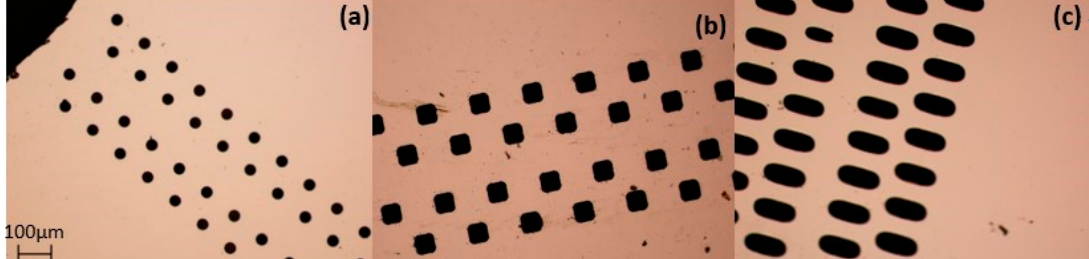
Figure 3. Silicon substrate sample for electroplating, obtained with an optical microscope. ( a ) circle, ( b ) square, and ( c ) oval holes.